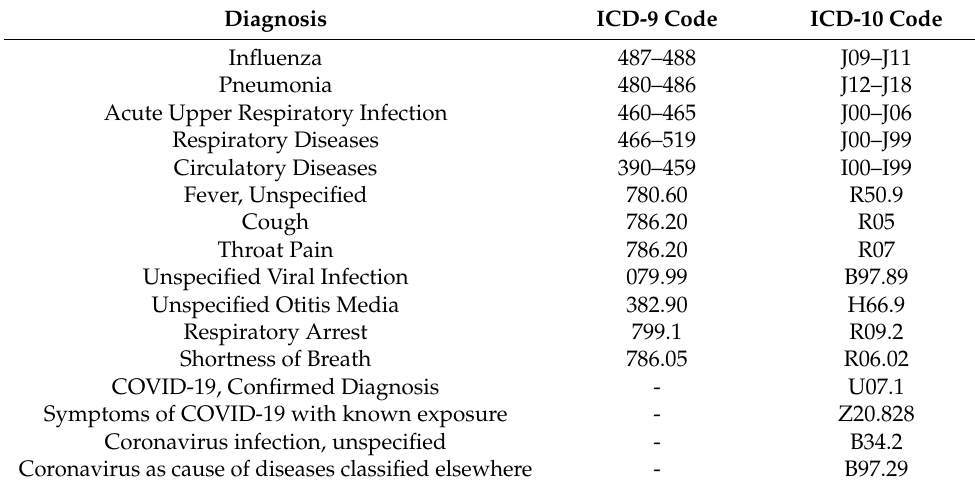
Table 1. ICD-9 Or ICD-10 Codes Utilized to Extract Data from the Institutional Data Warehouse at the University of Arkansas for Medical